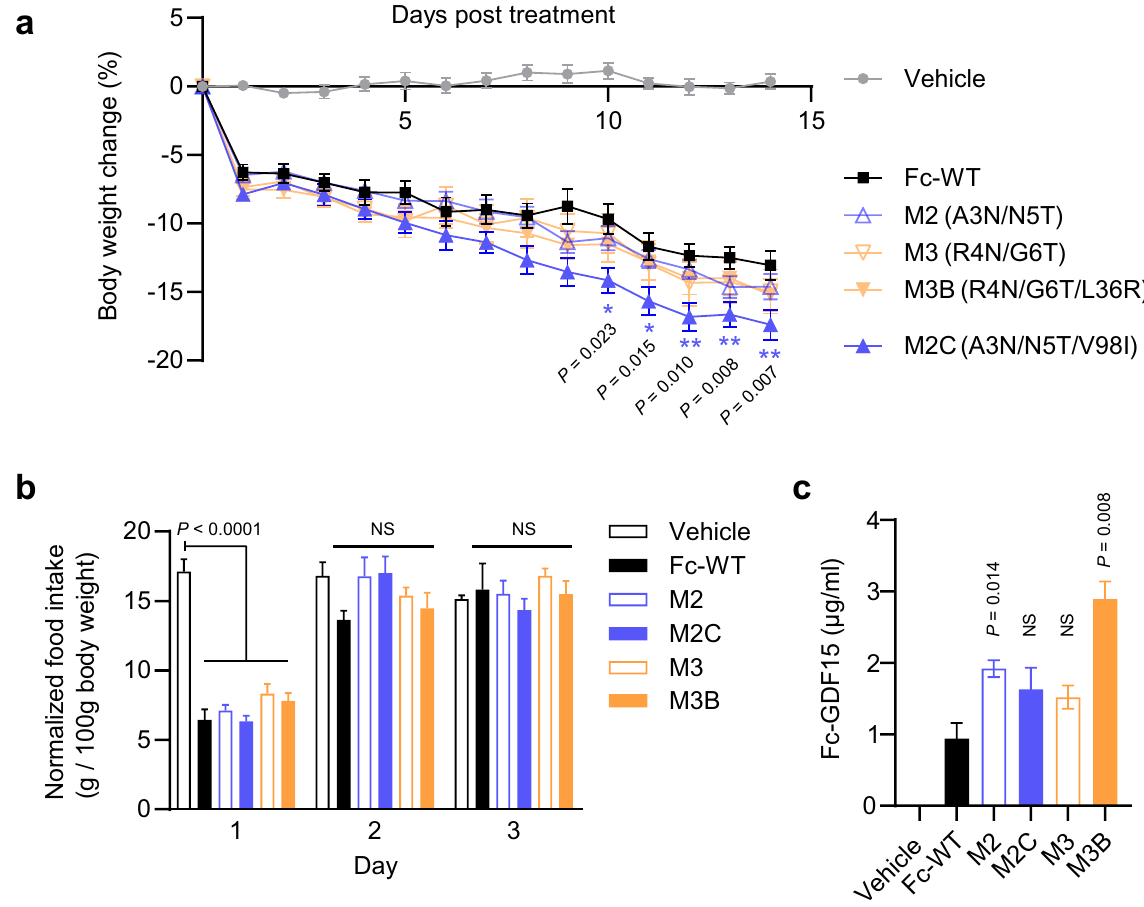
Figure 5. Fc-GDF15 Mutant 2C (A3N/N5T/V98I) has improved weight loss efficacy in vivo. ( a ) Body weight change after a single subcutaneous dose of the indicated Fc-GDF15 variant or the wildtype Fc-GDF15 (Fc- WT) control. Dose, 0.5 mg/kg. n = 7–10 per group. Data are reported as mean ± SEM * P ≤ 0.05, ** P ≤ 0.01 for Fc-GDF15 WT treatment as compared to all other treatments. Mixed effects model followed by Tukey’s post hoc test. ( b ) Daily food intake normalized to body weight following Fc-GDF15 treatment in ( a ). Data are reported as mean ± SEM; NS, P > 0.05. Mixed effects model followed by Tukey’s post hoc test. ( c ) Serum concentration of Fc-GDF15 variants on Day 14. Data are reported as mean ± SEM and analyzed with a pairwise Wilcoxon test. NS, P >